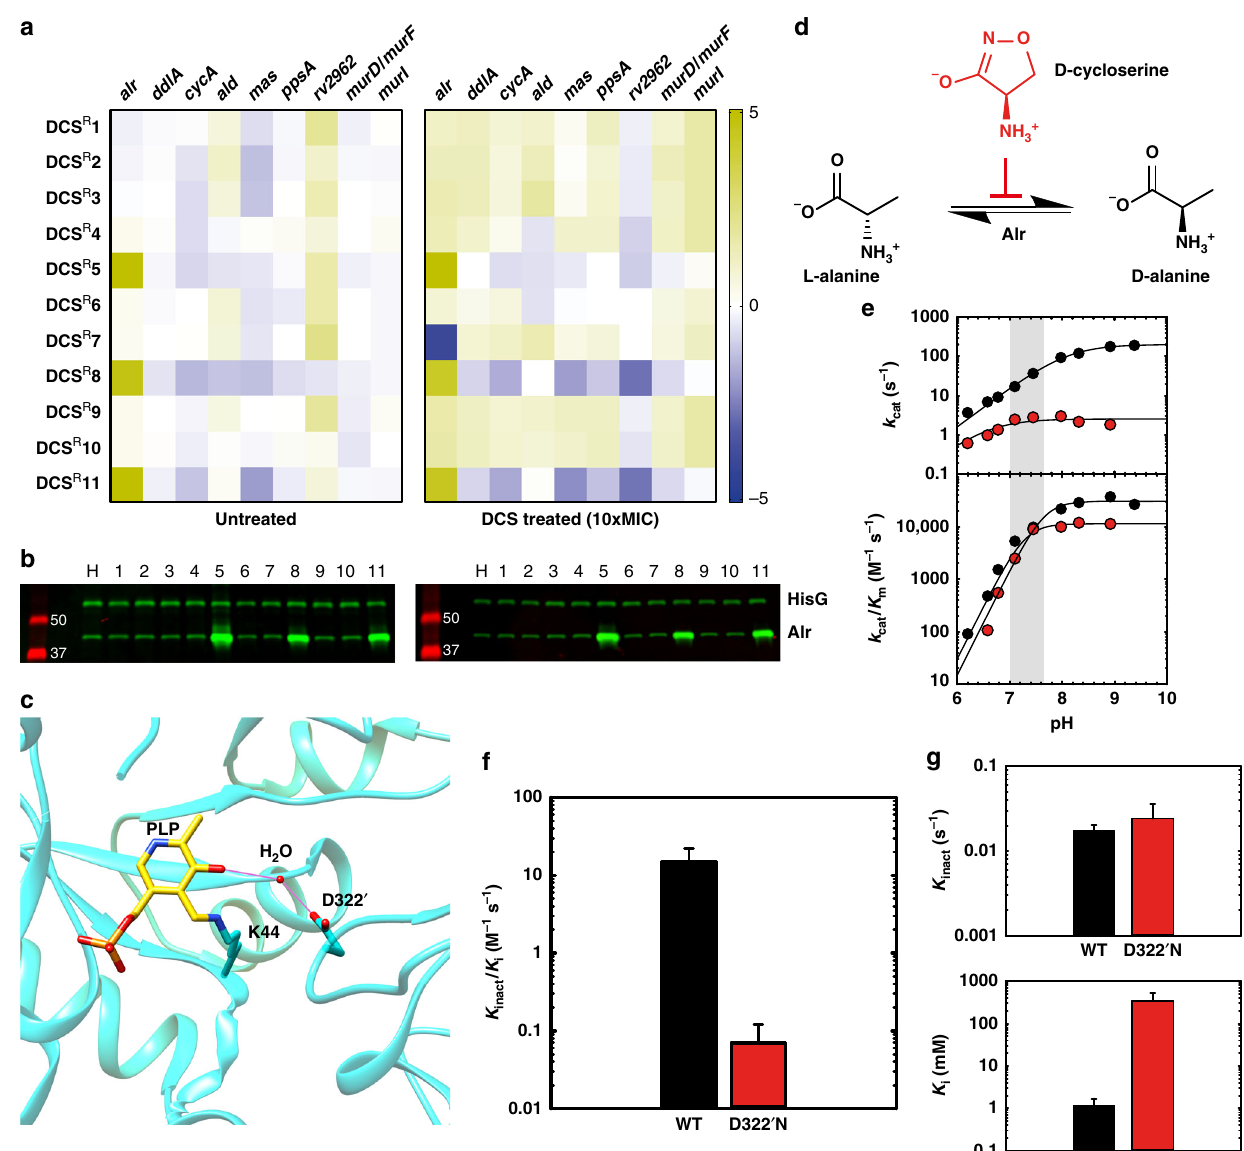
Fig. 3 Cellular and molecular determinants of DCS resistance in M. tuberculosis . a qPCR results for differential gene expression (log 2 transformed) of selected genes in the DCS R mutants grown in the absence or presence of DCS (10× MIC for 4 h). The results are representative of three biological replicates, n = 3. b Western blot analysis of Alr expression in the DCS R mutants and parent strain grown in the presence or absence of DCS (10 ×MIC for 4 h). HisG levels were used as loading control. The data are representative of two independent experiments. c Illustration of the active site of Alr from M. tuberculosis , 1XFC [https://www.rcsb.org/structure/1XFC] highlighting the location of residue D322 and its interactions with the pyridoxal 5 ’ -phosphate cofactor through a water molecule-hydrogen bond network. d Reaction catalyzed by Alr and its inhibition by DCS. e pH-rate pro fi le of the reaction catalyzed by wild-type